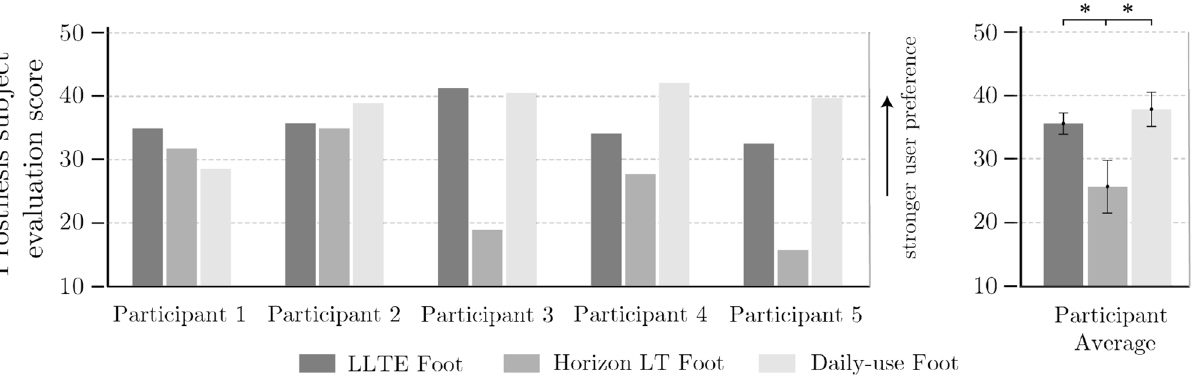
Figure 6. Participants’ prosthesis evaluation scores along with participant-averaged scores for the different prosthetic conditions. Statistical differences are denoted by an asterisk